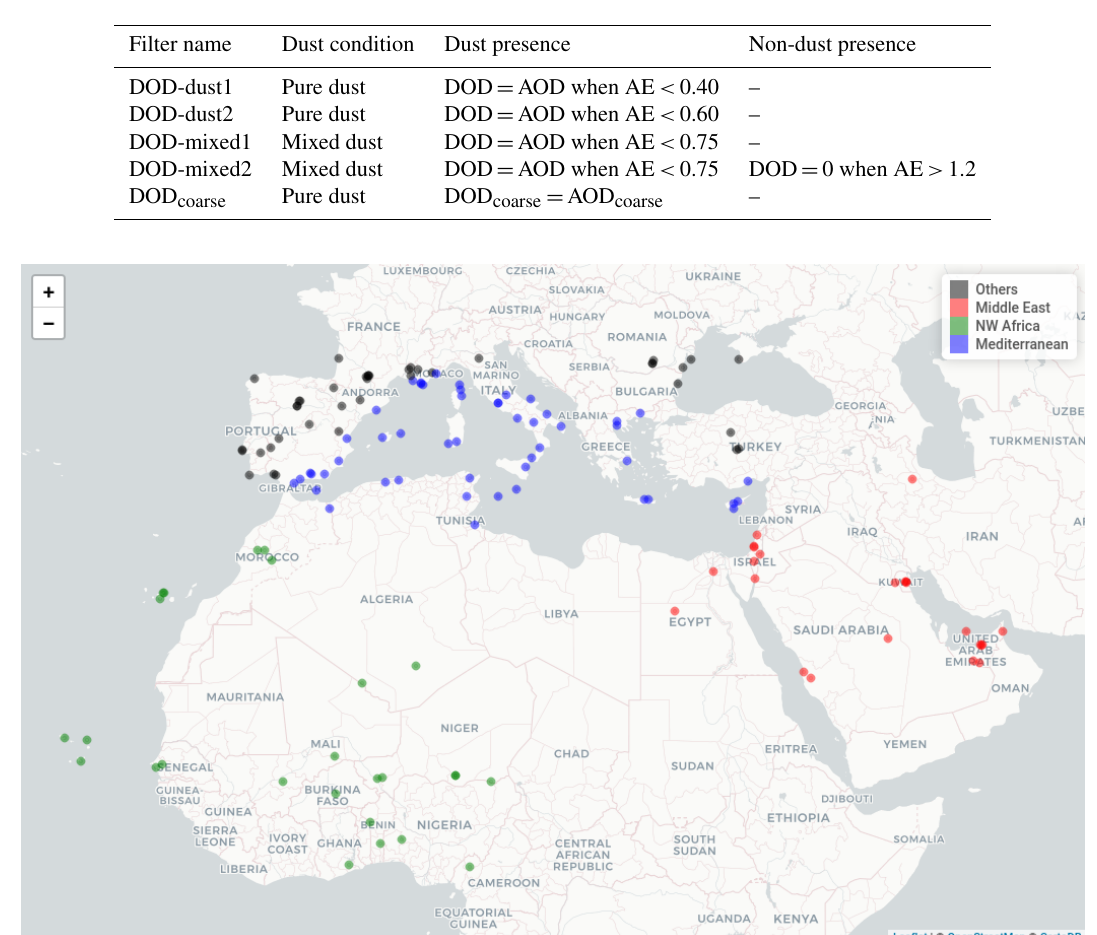
Figure 9. Spatial distribution of the AERONET sites used in this study. The different colours indicate the sub-regions considered in the discussion of the results: northwestern Africa (green), the Middle East (red) and the Mediterranean (blue). When validating the NAMEE region, all the sites are considered, including the ones labelled “Others” (black). © OpenStreetMap contributors 2022. Distributed under the